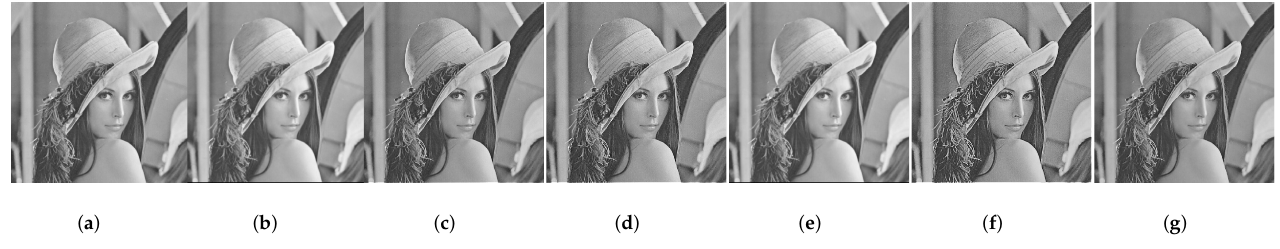
Figure 7. The renderings of Lena image under different algorithms. ( a ) Original image. ( b ) 1-order. ( c ) 0.4-order. ( d ) 0.6-order. ( e ) [17]. ( f ) [19]. ( g )